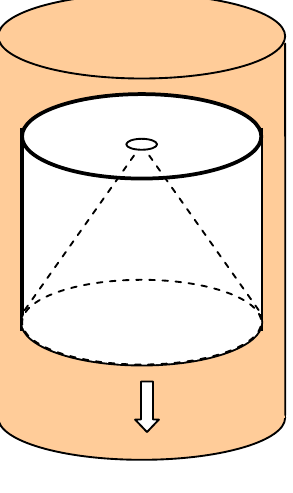
Figure 12. Sketch of a plexiglass cylinder with a conical cavity moving in a cylindrical ECVT